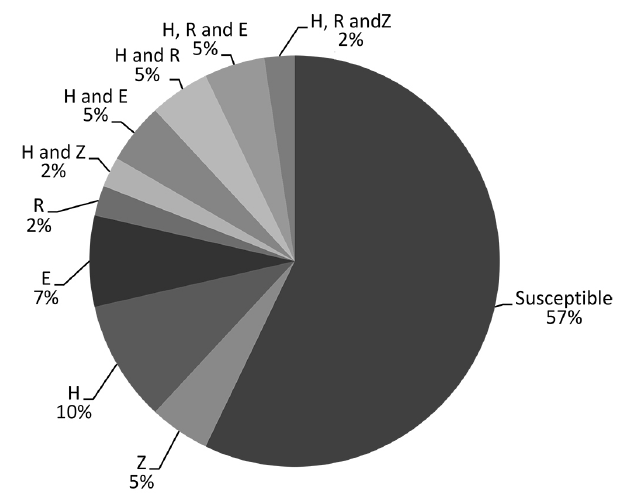
FIGURE 1 - Percentage of resistant strains by the proportions method. Rifampicin (R), isoniazid (H), pyrazinamide (Z), ethambutol (E).